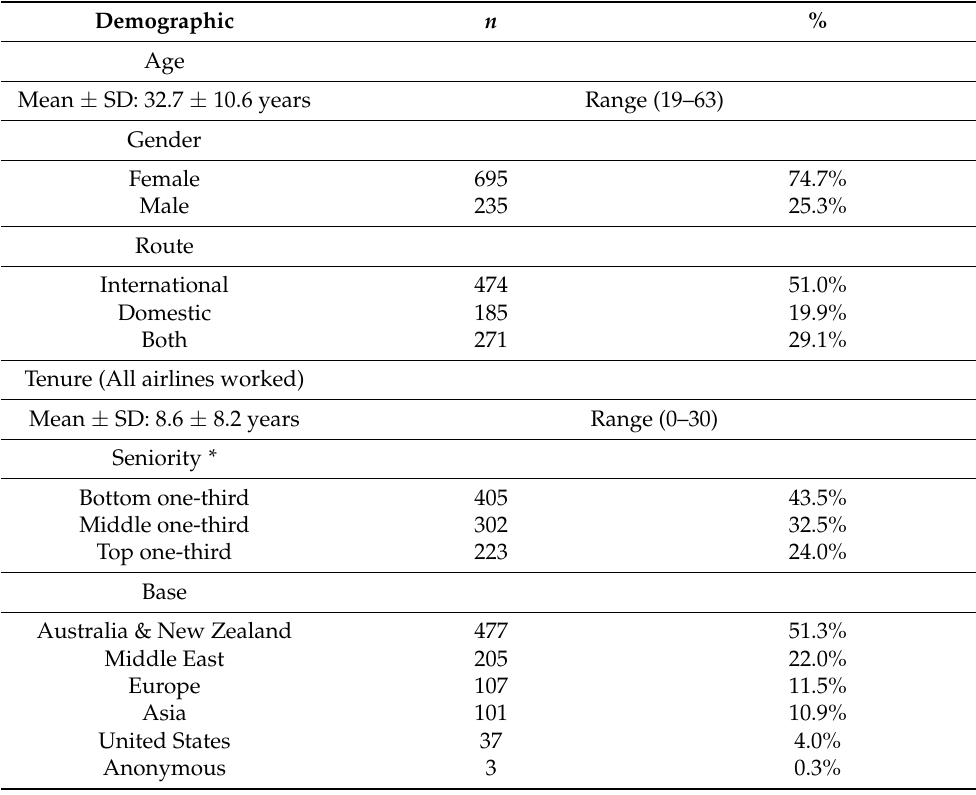
* Bottom one-third: Economy Class cabin crew. Middle one-third: Business/First Class Crew. Top one- third: Purser/Management